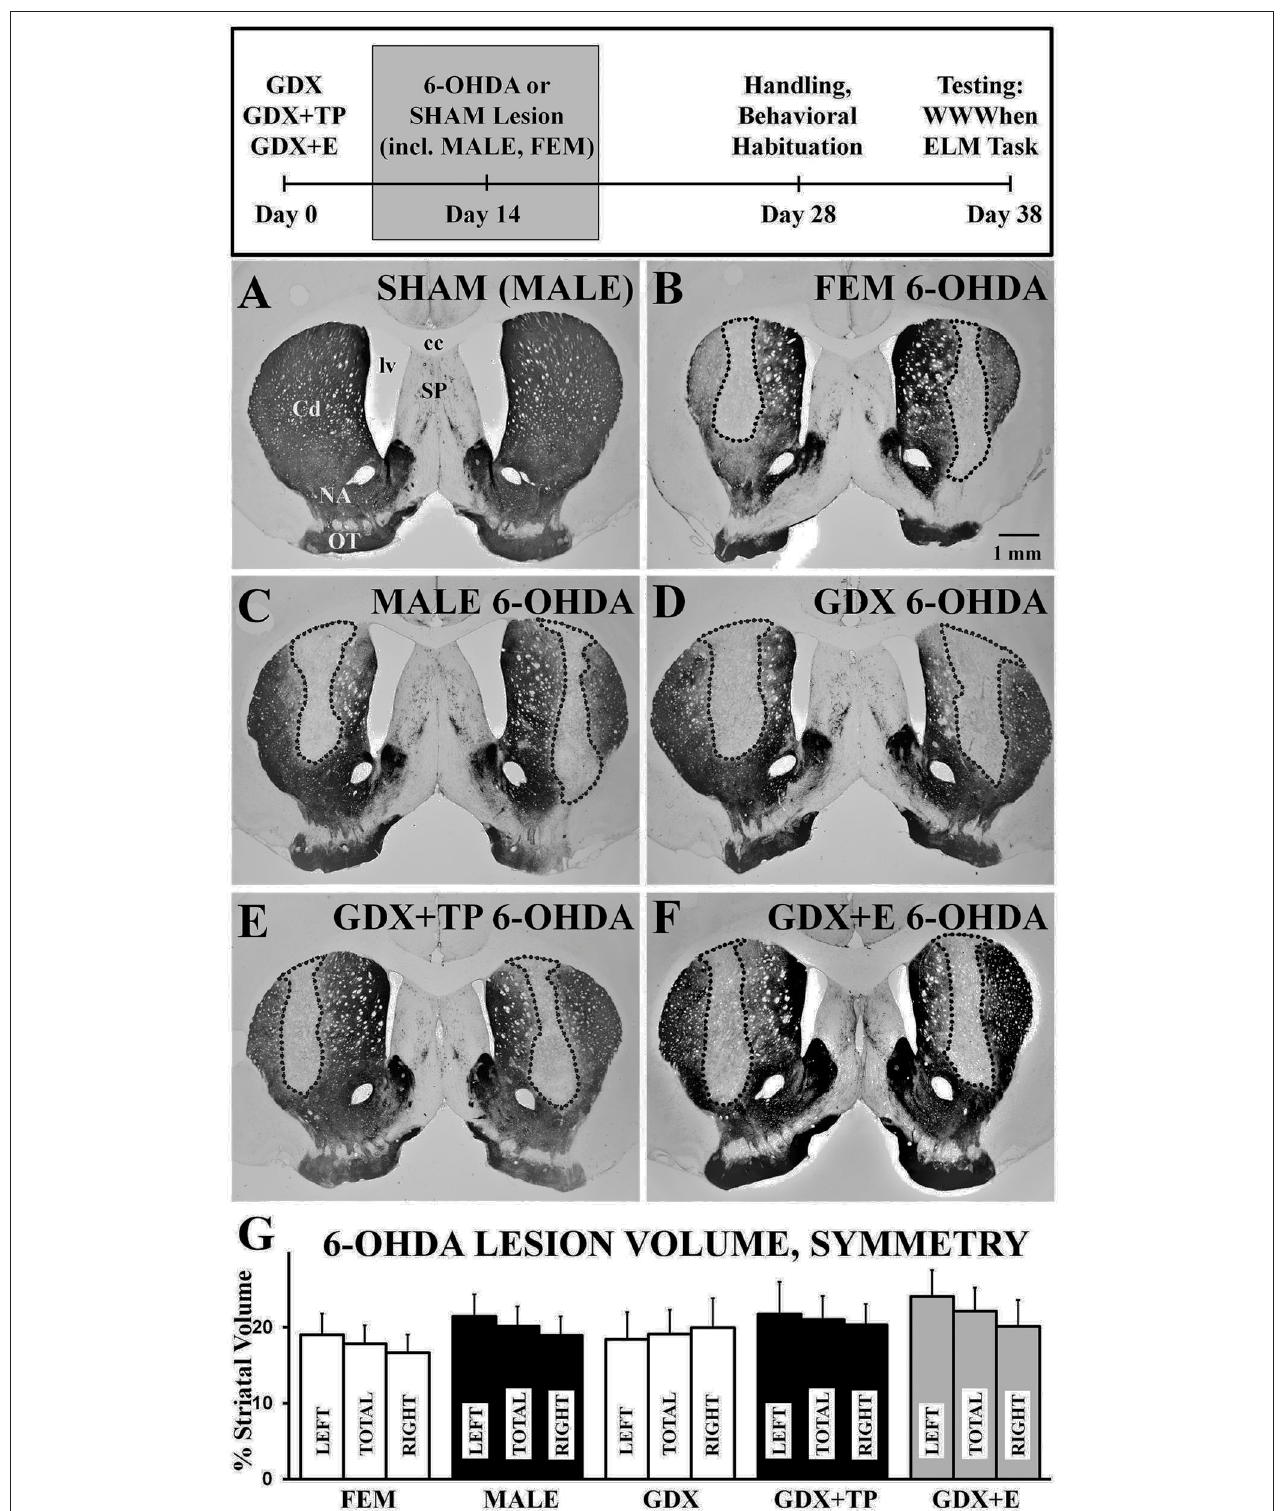
FIGURE 2 | Representative low-power, brightfield light microscopic images of coronal sections through septal levels of the caudate nucleus (Cd) that are immunoreacted for tyrosine-hydroxylase (TH) (A–G) . The section from a gonadally intact sham-operated male ( A , SHAM) shows dense labeling throughout